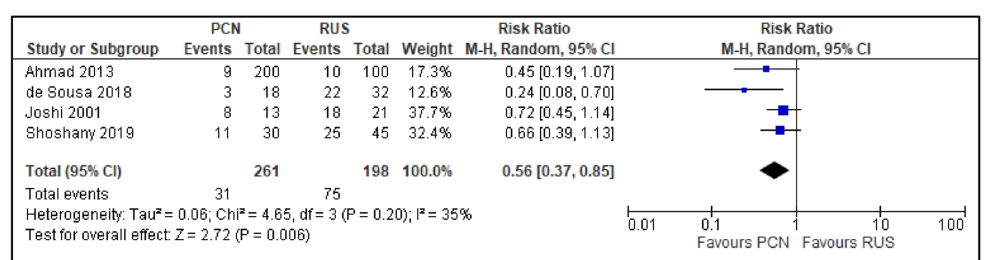
Figure 11. Comparison between PCN and RUS for outcome QoL – anxiety/depression.